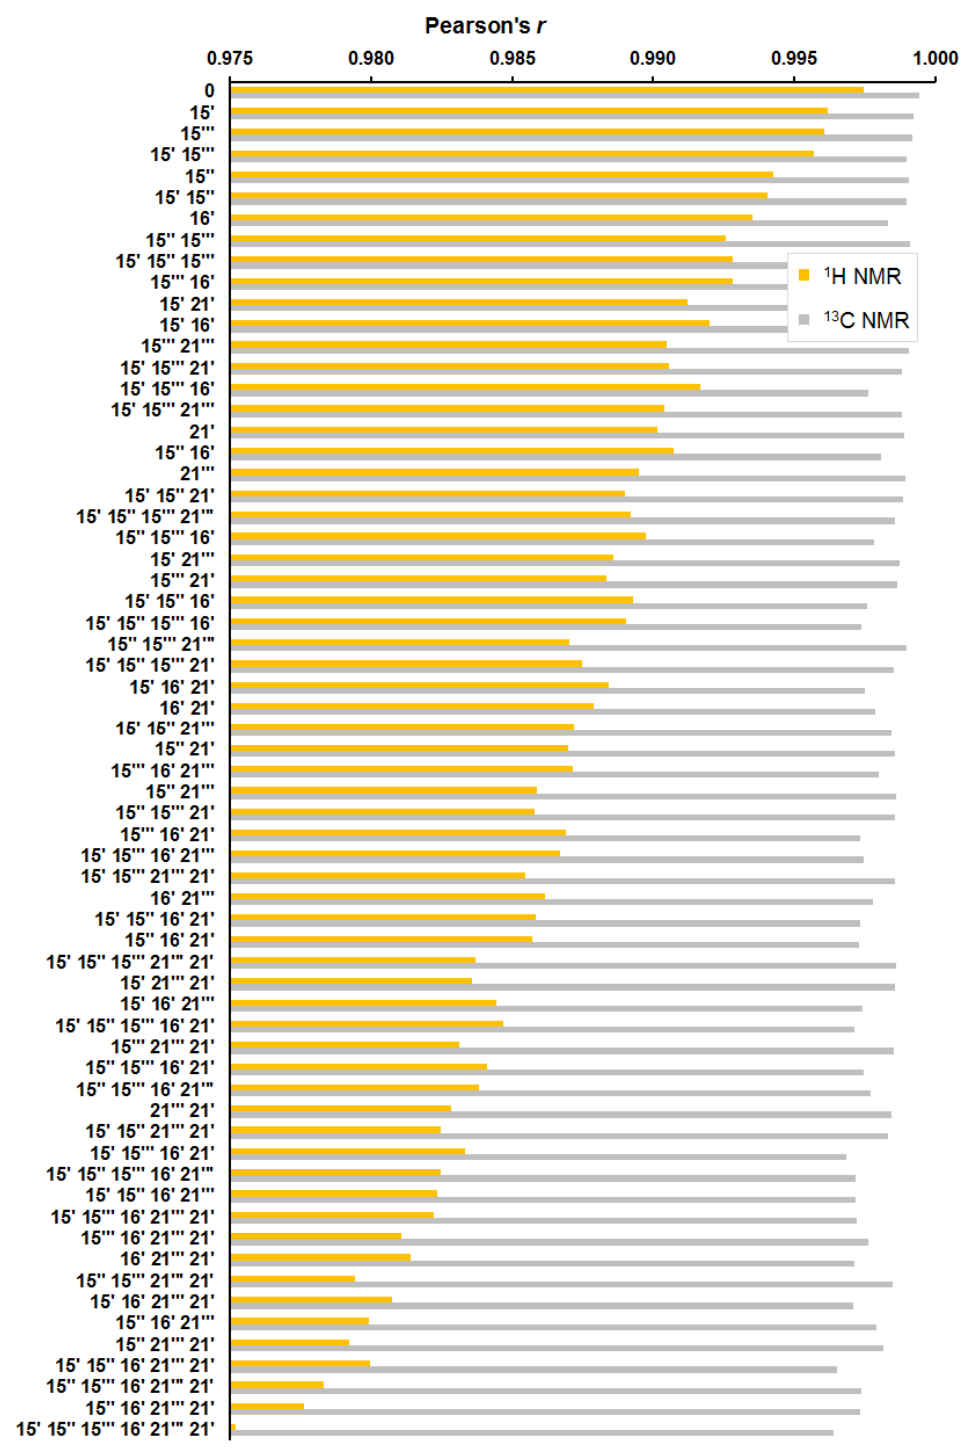
Figure 10. Distribution of Pearson’s correlation coefficient of 64 alternate diastereomers of alasmontamine A.